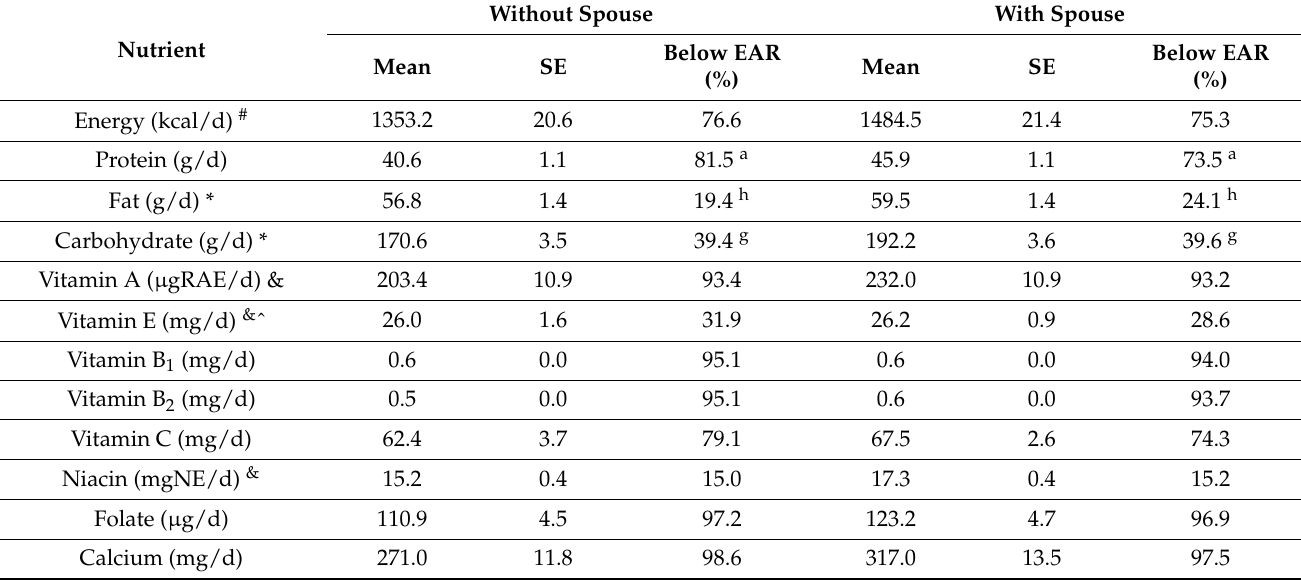
Table 6. Dietary daily intake of energy and nutrients and the prevalence of deficiency in the subjects aged 80 and above in different marital